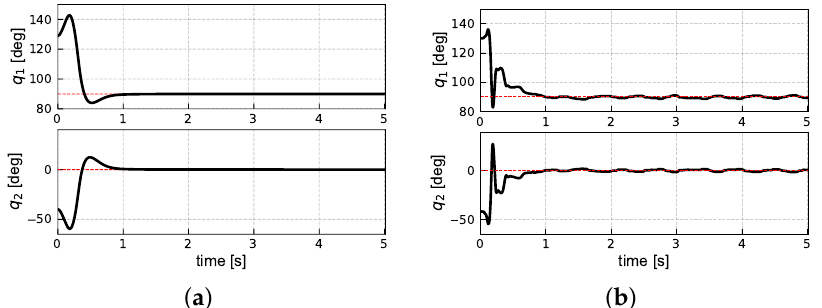
Figure 7. Case A2: Angular positions: ( a ) simulation, ( b ) experiment.